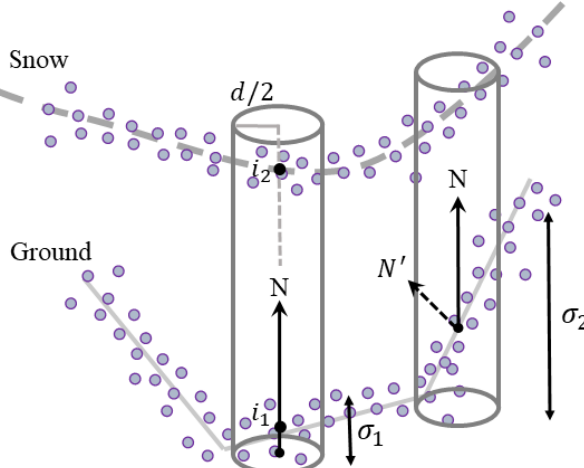
Figure B1. M3C2 method for computing snow depth. Vector N shows the normal on the reference surface (ground) and d is the projection scale. Surface roughness is the standard deviation of the point clouds within the cylinder ( σ ). Misorientation on rough surfaces ( N (cid:48) ) is seen by high standard deviation ( σ 2 ) and is resolved by choosing the proper normal scale. Snow depth is the vertical distance between the average positions of ground and snow point clouds within the cylinder (distance between i 1 and i 2 ). Redrawn from Lague et al. (2013).